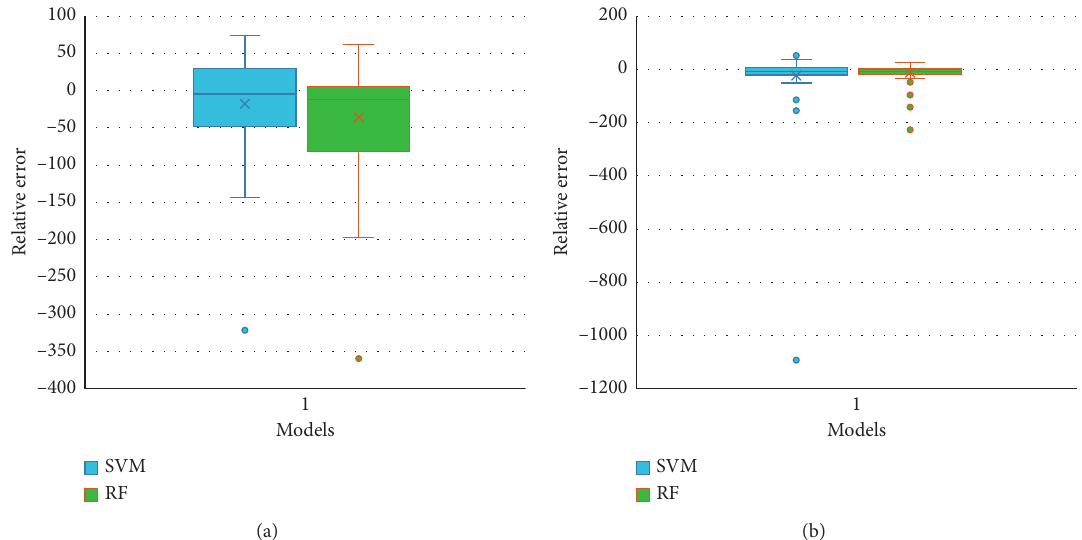
Figure 5: The relative error for the applied predictive models (RF and SVM) over the testing phase. (a) Model 1. (b) Model